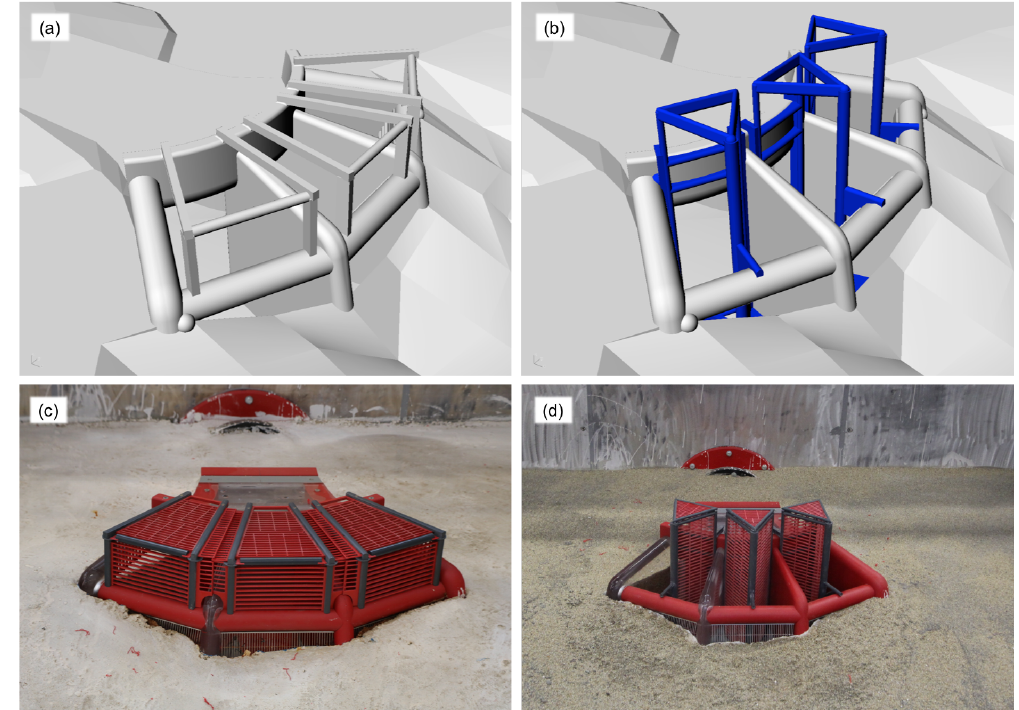
Figure 2. Digital model ( a , b ) and dry scale model ( c , d ) of the two trash rack options—build-on variation E 01 (left) and triangle structure E 02